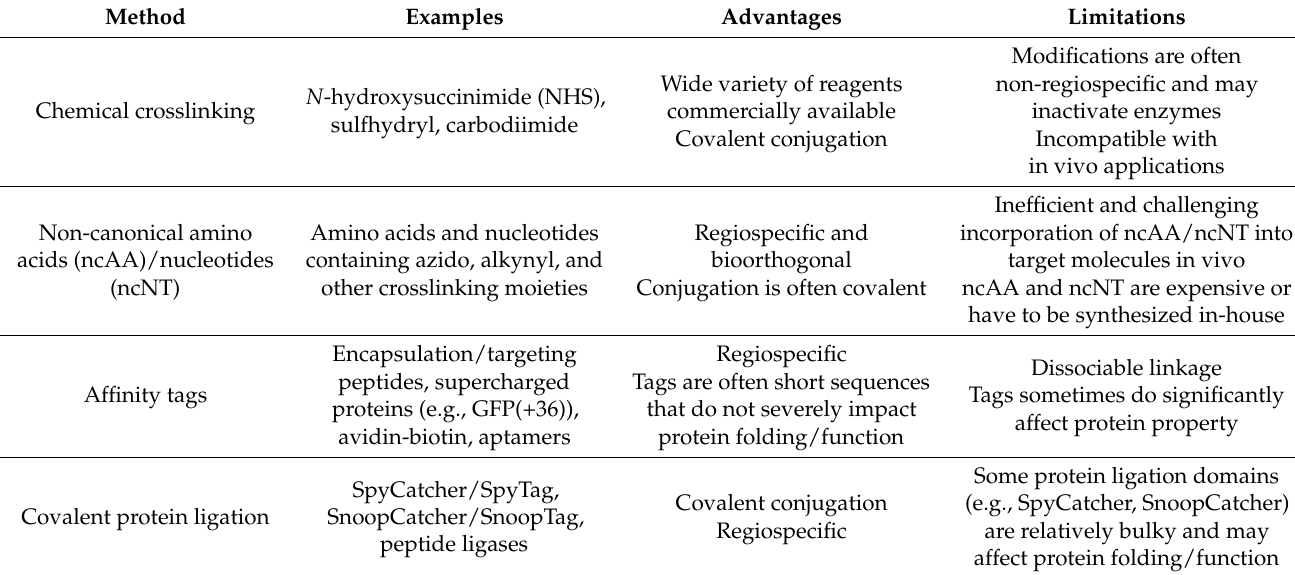
Table 2. Examples of widely adopted methodologies for installing enzymes onto